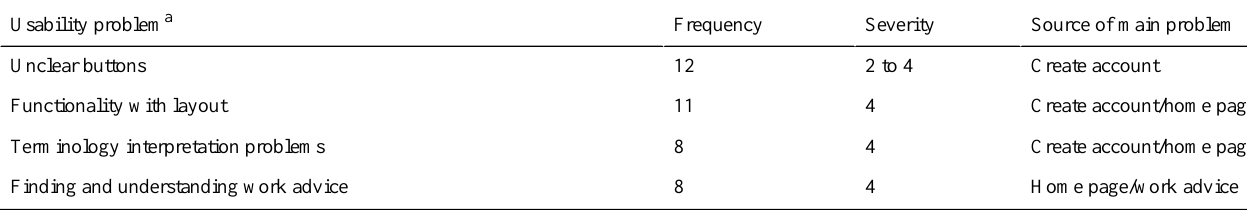
Table 3. Overview of severe usability problems per main problem